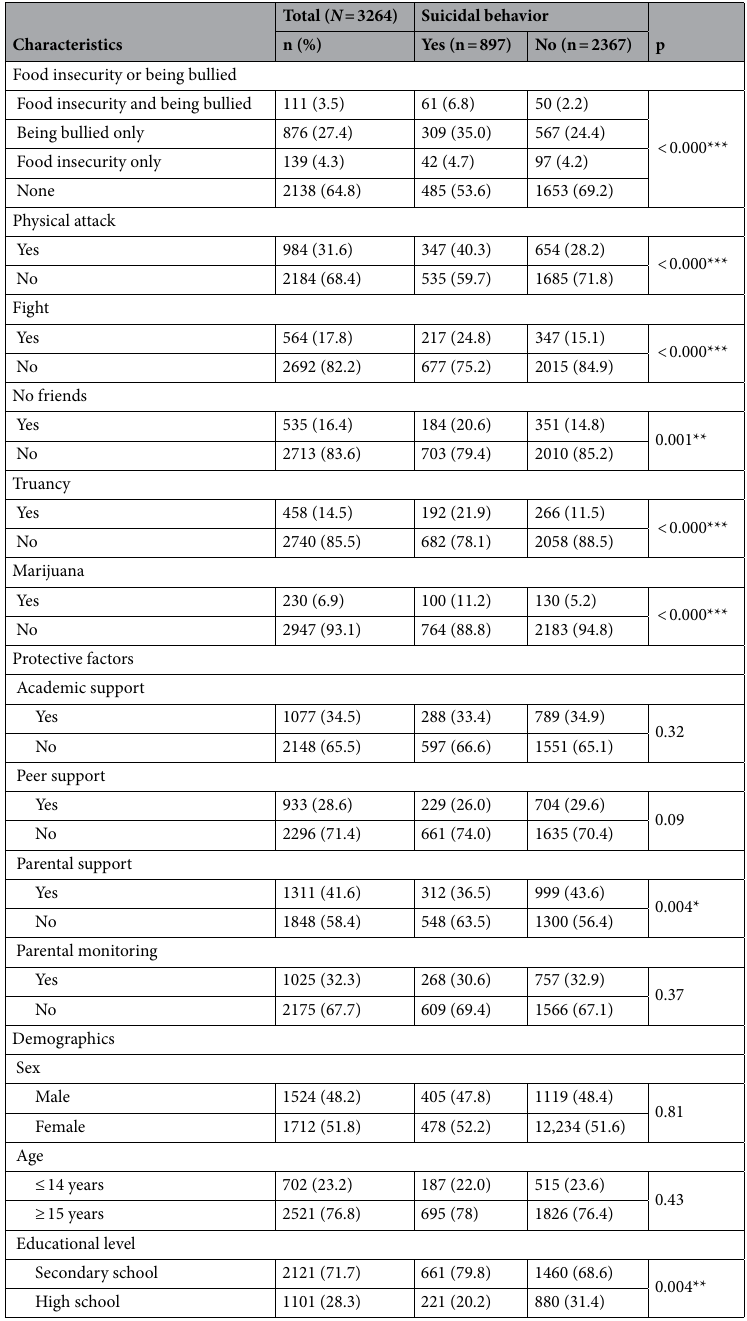
Table 1. Distribution of suicidal behavior in association with food insecurity and being bullied. *p < 0.05, **p < 0.01, ***p <